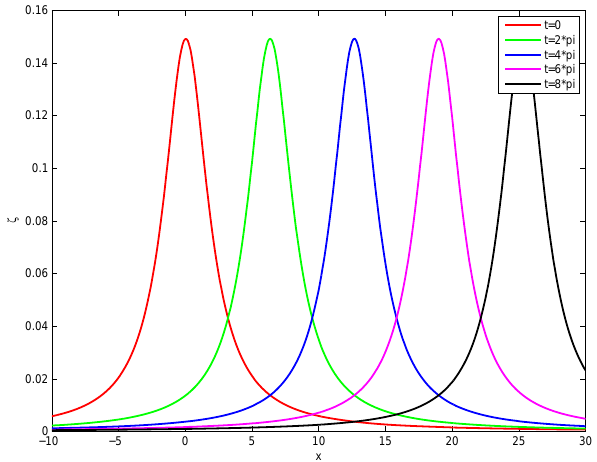
Figure 1. A cross section of the perturbation in ρ at z =